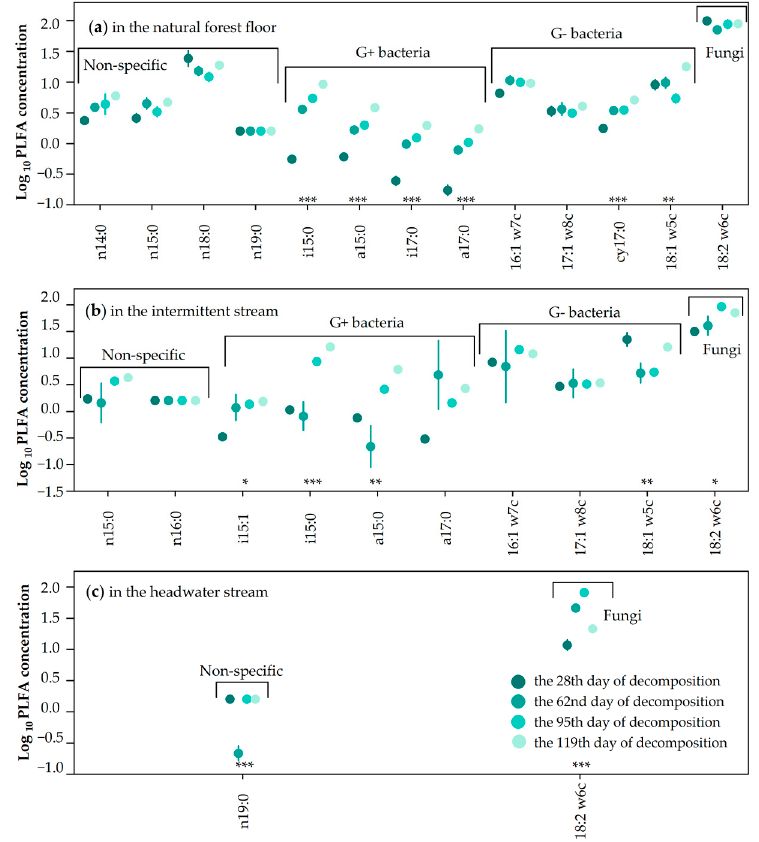
Figure 3. Concentrations of individual PLFA in ( a ) the natural forest floor and ( b ) the intermittent stream and ( c ) the headwater stream leaf litter. Asterisks indicate significant differences among decomposition time: * p < 0.05, ** p < 0.01, *** p < 0.001. Dots indicate the mean and whiskers the standard error.